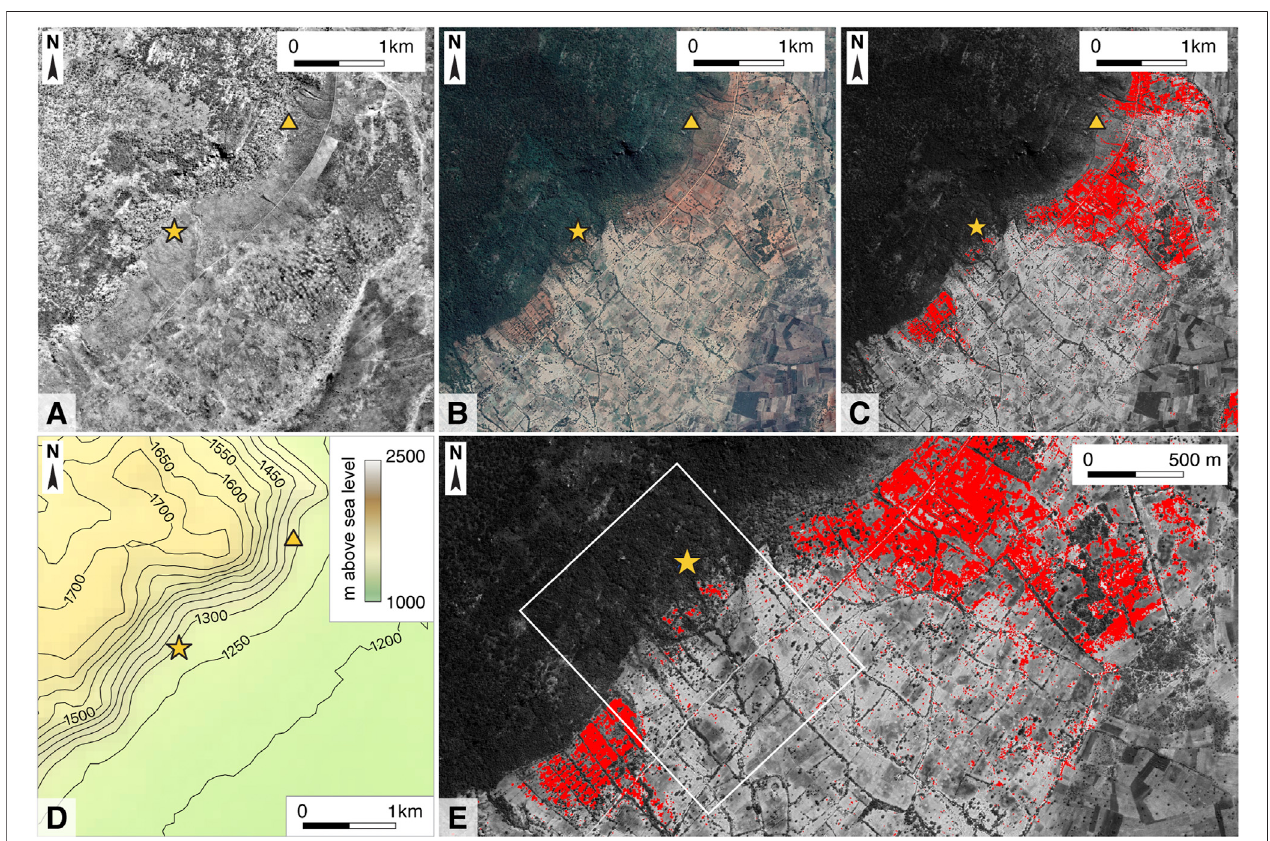
FIGURE 6 | Comparison of historic and modern aerial imagery around the wider region surrounding Kisese II. The triangle denotes the location of Kisese I, and the star denotes the location of Kisese II. Location of the site is indicated by a star. (A) Historic aerial photograph taken in 1960 (Directorate of Overseas Surveys archives, National Collection ofAerial Photography, Scotland, NCAP/ncap.org.uk). Note the extentof deforestation well beyond the summitof the Irangi Hills. (B) Modern satellite imagefromGoogleEarth. (C) GreyscaleversionofmodernGoogleEarthimagery,withareascorrespondingtoexposedferriclixisolthroughanalysisinIDRISISelva overlaid in red. (D) Topographic map of the study area. (E) Enlargement of Figure 6C . The white box corresponds to the area de fi ned as the immediate landscape around Kisese II for the GIS analysis. It is clear that the landscape of Kisese II has been impacted the least.